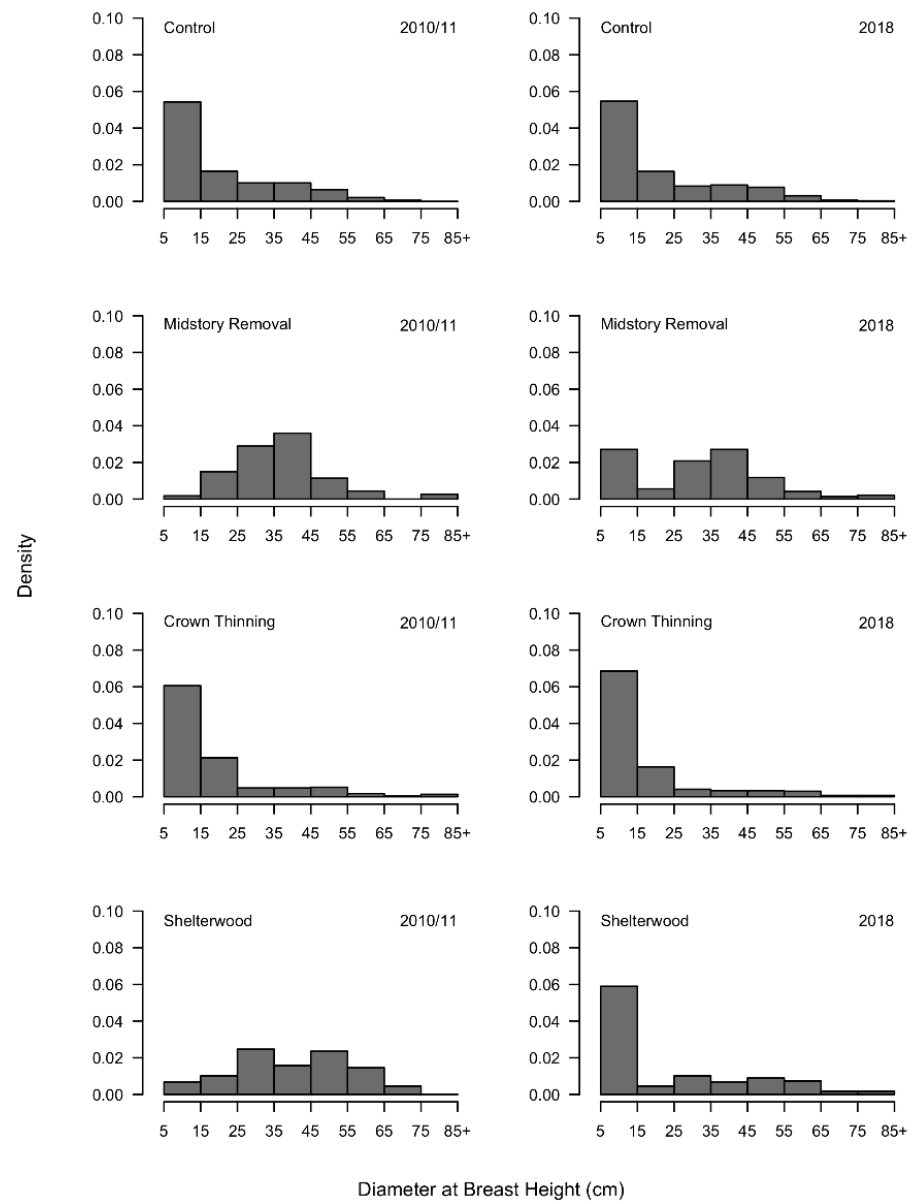
Figure 2. Size class distributions for all trees 5.1 cm dbh (diameter at breast height) and greater, three to four years and ten years after implementation of silvicultural treatments.